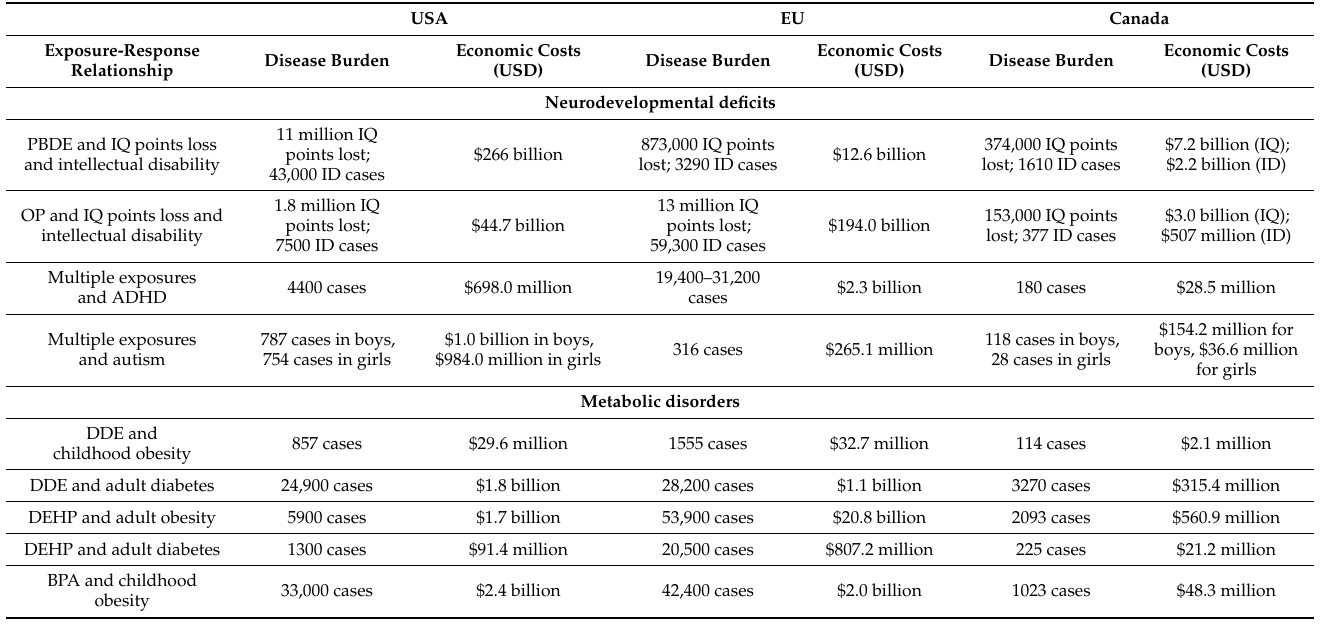
Table 3. Comparison of attributable disease burden and economic costs (base case estimates, 2010 USD) in the US, EU and Canada with 2010 population